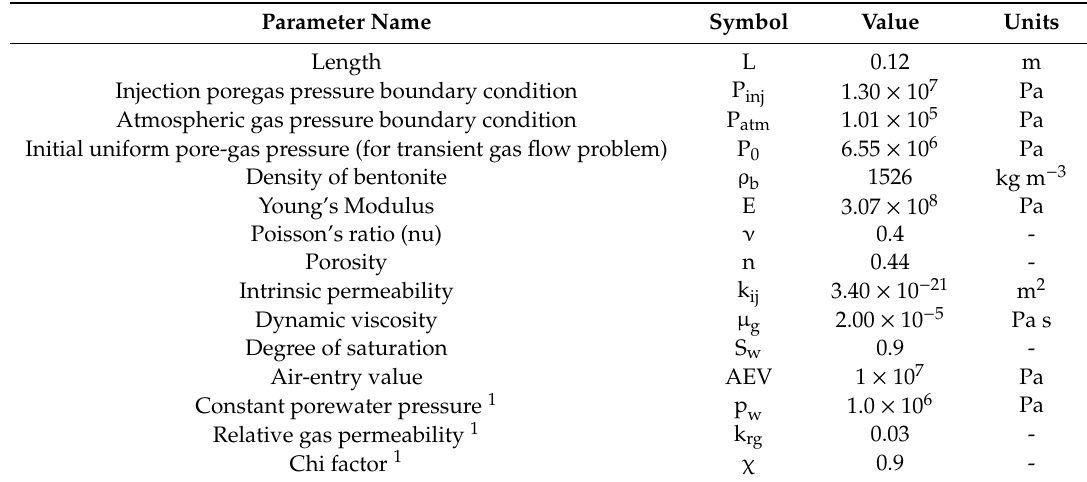
Table 1. Verification study parameters.